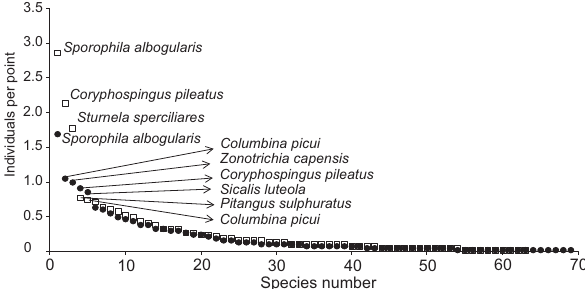
Figure 4. Abundance curve of bird species recorded with point counts (fixed radius of 50 m). Dry season (white squares) and rainy season (black